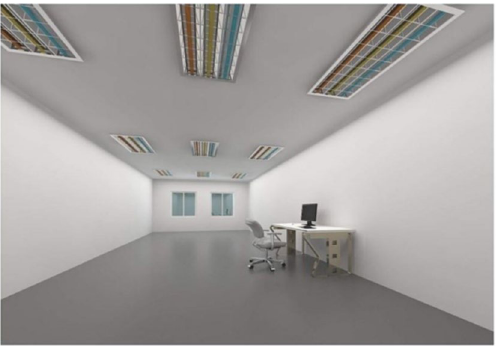
Figure 8. In the laboratory setting, nine controllable luminaires were installed on the ceiling, and black curtains were installed on the windows to block natural